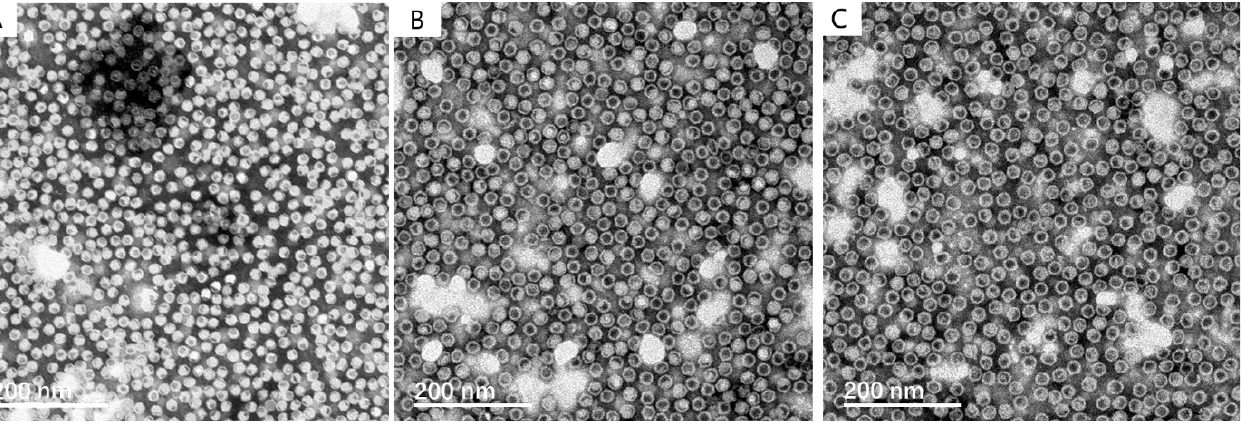
Figure 4. Morphological observation of the recombinant VP1/VP2 and VP1h/VP2 VLPs by using negative staining transmission electron microscopy (TEM), which was compared with that of the VP2 VLP produced by using the same Hansenula polymorpha expression system in our previous study [25]. ( A ): The TEM micrograph of the VP2 VLPs. This TEM graph was taken by the same sample but in a slightly different scope, with permission from Ref. [25] published by Chinese Journal of Microbiology and Immunology, 2020. ( B ): The TEM micrograph of the VP1/VP2 VLPs. ( C ): the TEM micrograph of the VP1h/VP2 VLPs.